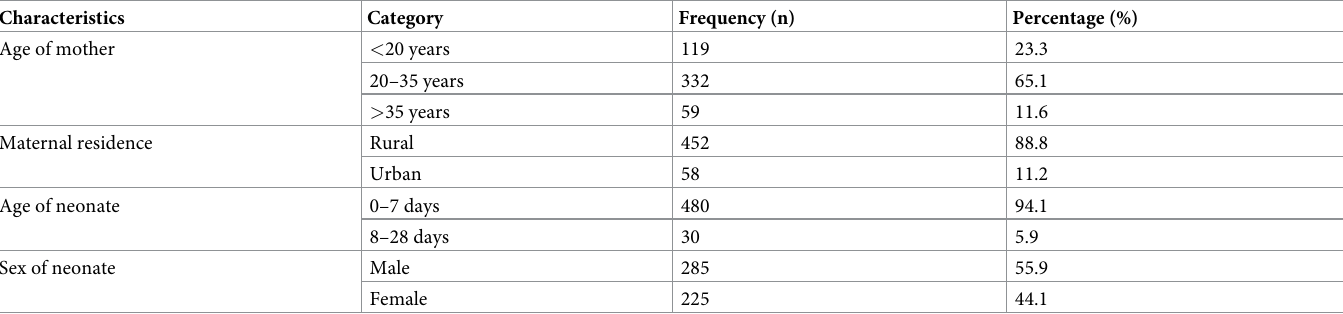
Table 1. Socio-demographic characteristics of neonates admitted to NICU of selected public Hospitals in Somali Regional State, Eastern Ethiopia, 2020.